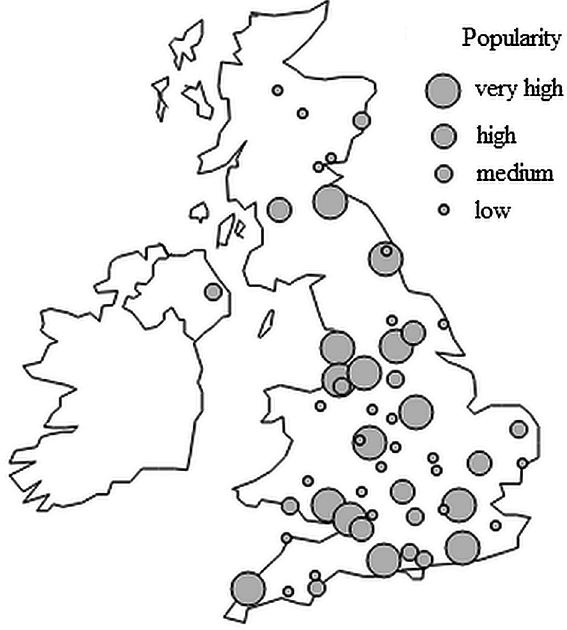
Fig. 3. Popularity of British stag party tourism centres based on the analyzed